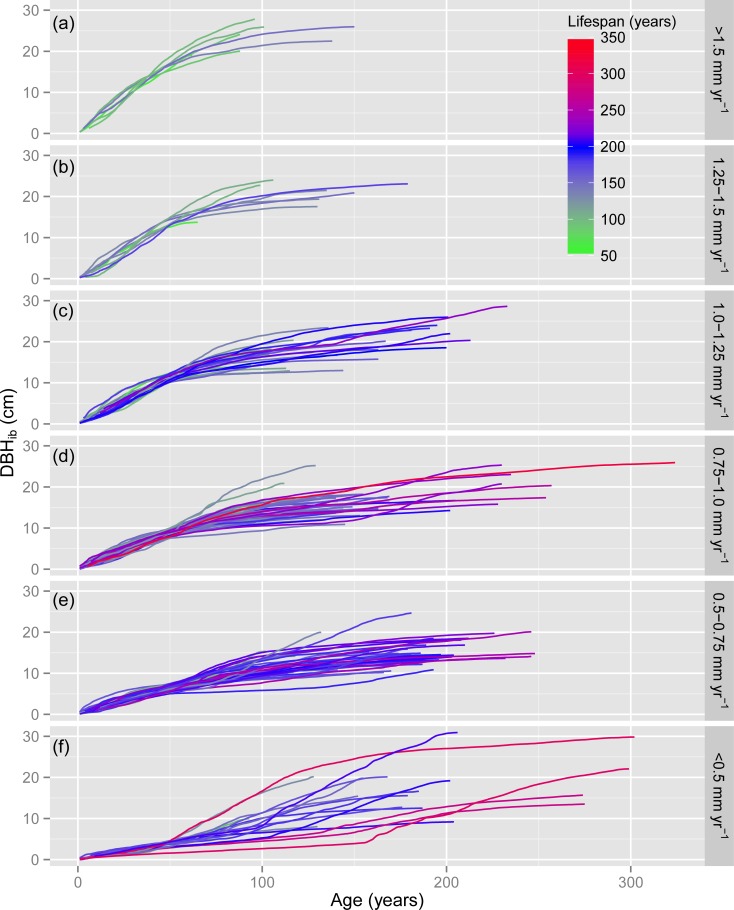
Development of tree size with age.Tree size is represented by DBHib (diameter at breast height inside bark); the color gradient indicates the lifespan of the mountain pines. Trees were assigned to classes of early growth (mean ring width over the first 50 years): (a) > 1.5 mm yr-1 (n = 7 trees); (b) 1.25–1.5 mm yr-1 (n = 8 trees); (c) 1.0–1.25 mm yr-1 (n = 27 trees); (d) 0.75–1.0 mm yr-1 (n = 54 trees); (e) 0.5–0.75 mm yr-1 (n = 46 trees); (f) <0.5 mm yr-1 (n = 18 trees).